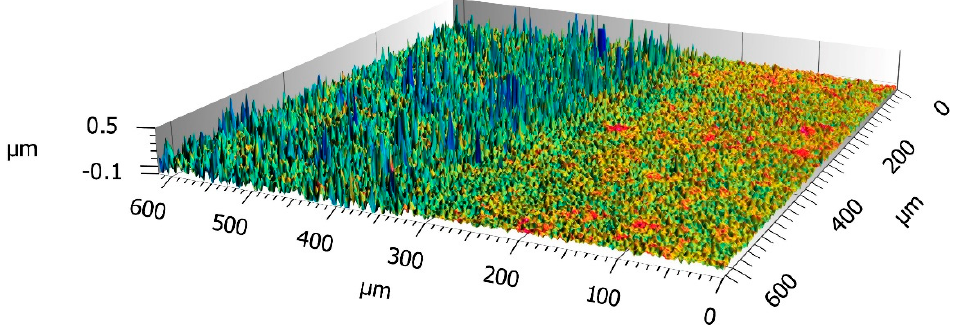
Figure 11. 3D images of SH sample (T = 90%, Sa = 52 nm and 57% Cov. Area as Figure 9) immersed at pH > 13. The right side of the image is the part of the sample immersed into basic solution.